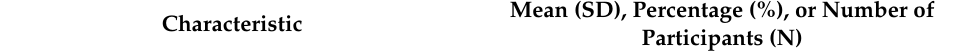
Table 1. Baseline characteristics